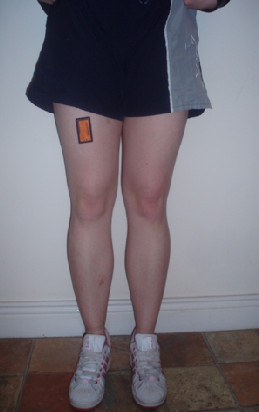
ActivPAL placement.